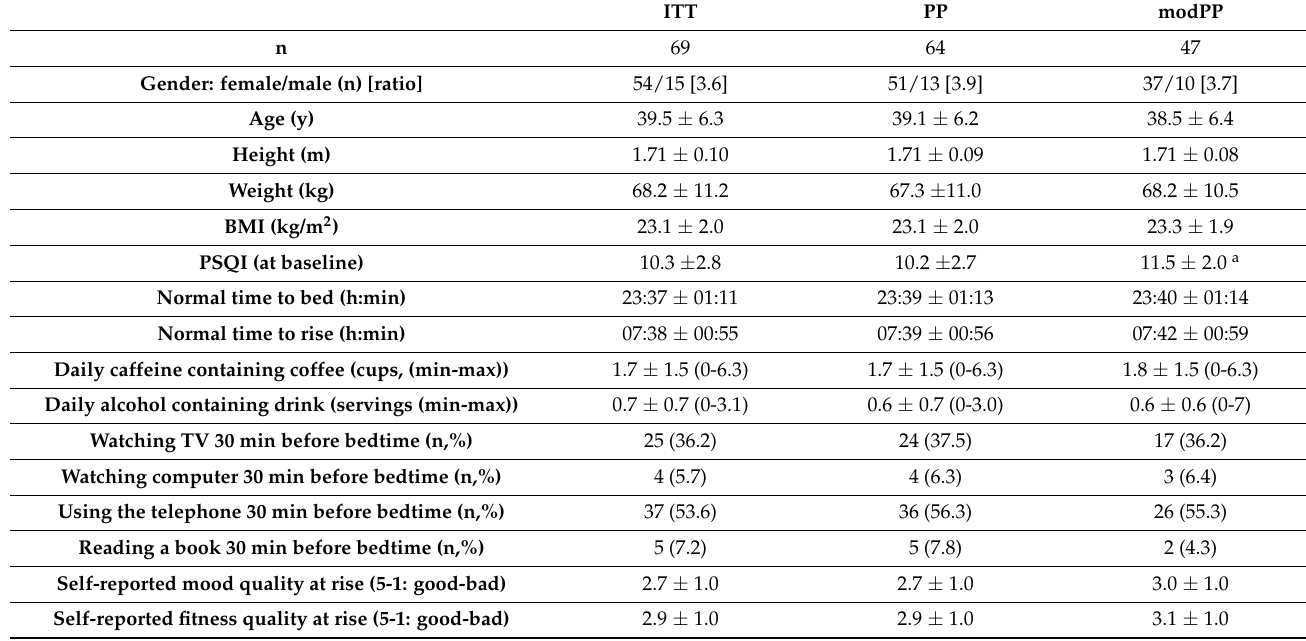
Table 2. General characteristics of study participants at the start of the study for the ITT, PP, and modPP study groups. ITT PP modPP 69